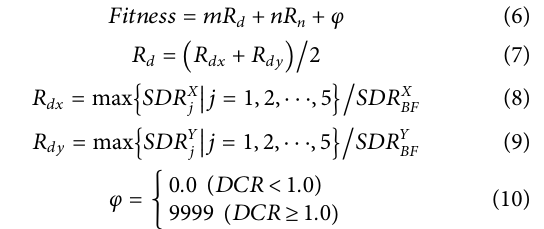
Frontiers in Built Environment |